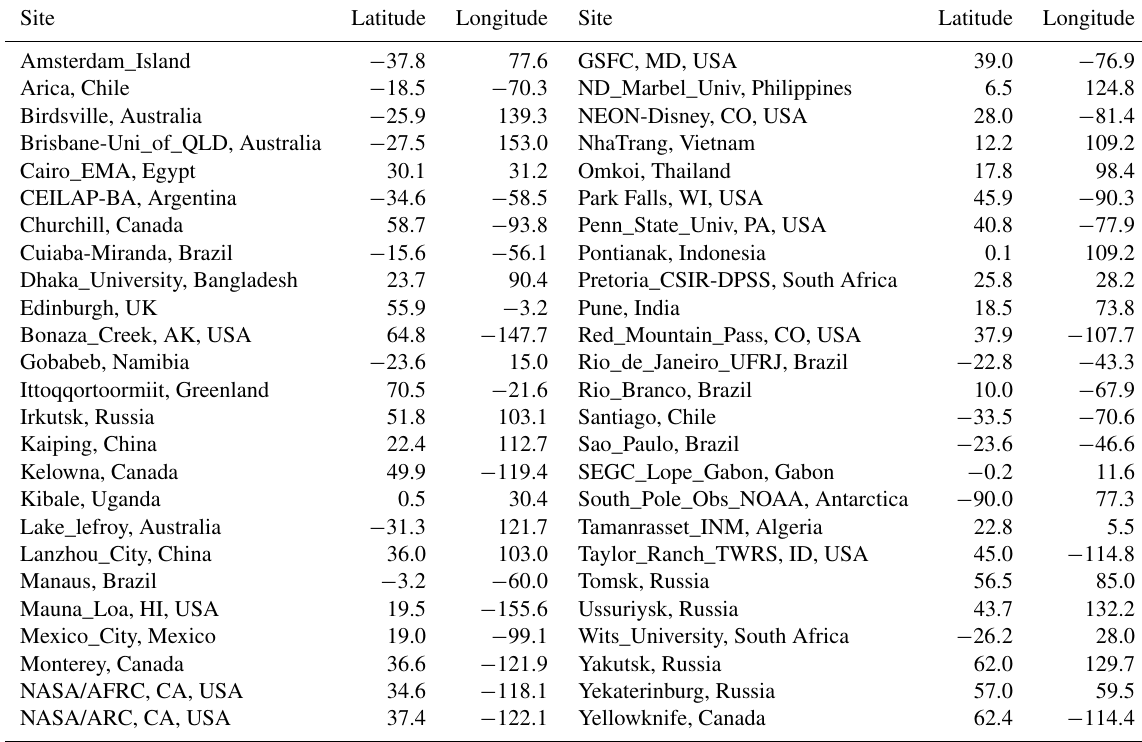
Figure 6. Distribution of annual mean residuals that describe the true state minus a priori and a posteriori CO 2 fluxes (10 14 moleccm − 2 s − 1 ), described on the 4 ◦ latitude × 5 ◦ longitude GEOS-Chem model grid. Table 2. List of 50 selected AERONET and NASA sites with mini-LHR installed in the future for the OSSE